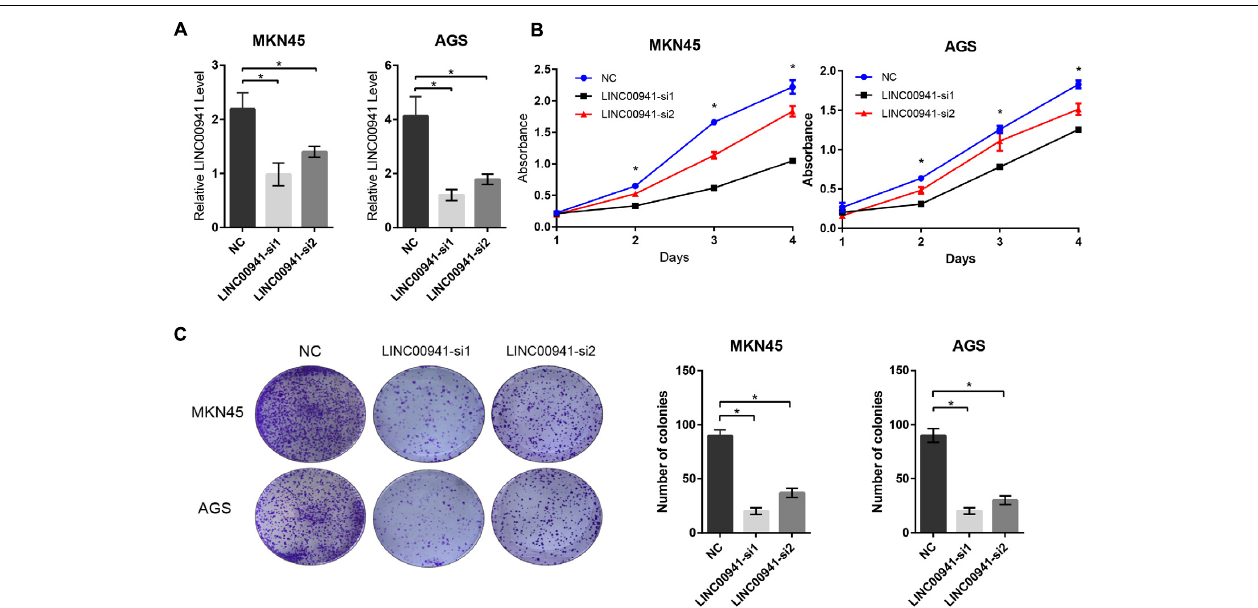
FIGURE 3 | Silence of LINC00941 inhibits GC cells proliferation in vitro . (A) LINC00941 was knocked down by siRNAs in MKN45 and AGS cells. (B) Silence of LINC00941 significantly inhibited the proliferation ability of MKN45 and AGS cells. The effect on cell proliferation was assessed over 4 days using the CCK8. (C) Colony formation ability of MKN45 and AGS cells was significantly decreased after silencing LINC00941 . Two-tailed Student’s t -test was used to analyze the significant differences, ∗ p < 0.05.